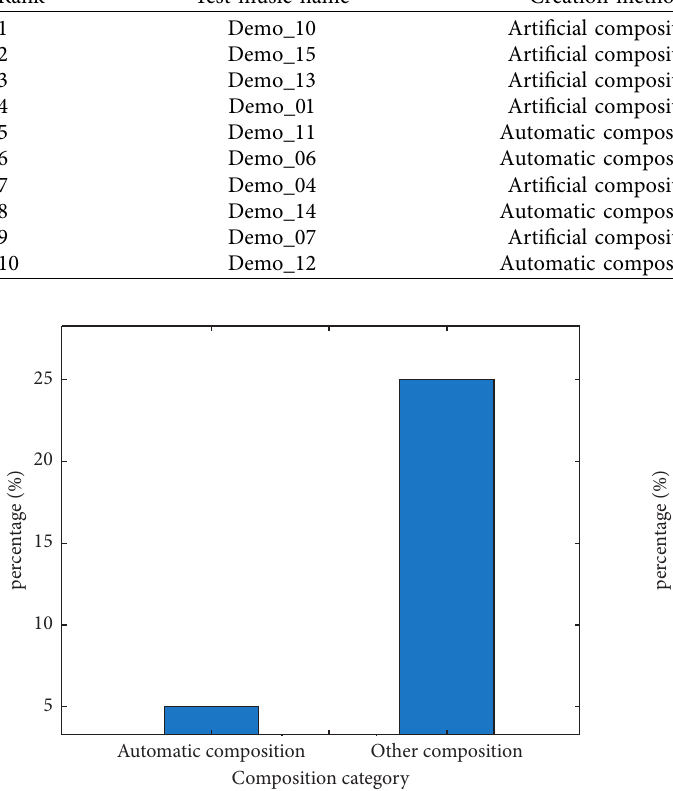
Figure 6: Percentage with a score of 80 points or more. Figure 7: Percentage with a score of 60 points or